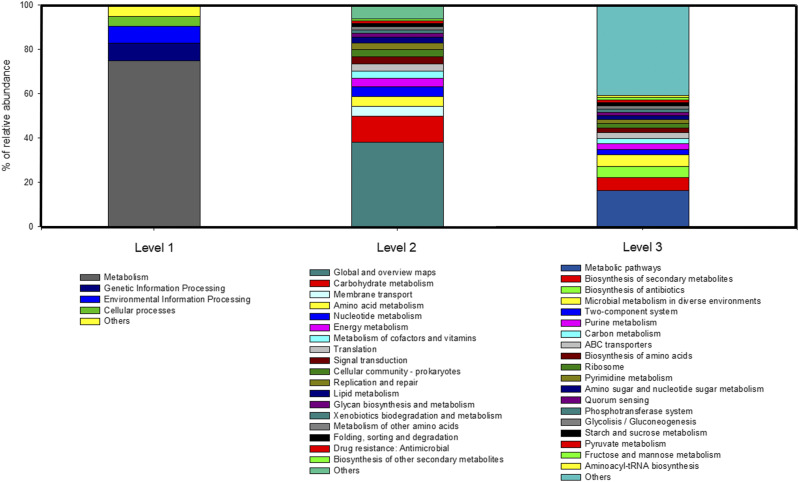
Functional predictions of different levels of classification. Bar plot for the percentage of relative abundances (y-axis) of the predicted functions (x-axis) at the three levels of classification based on KEGG database.